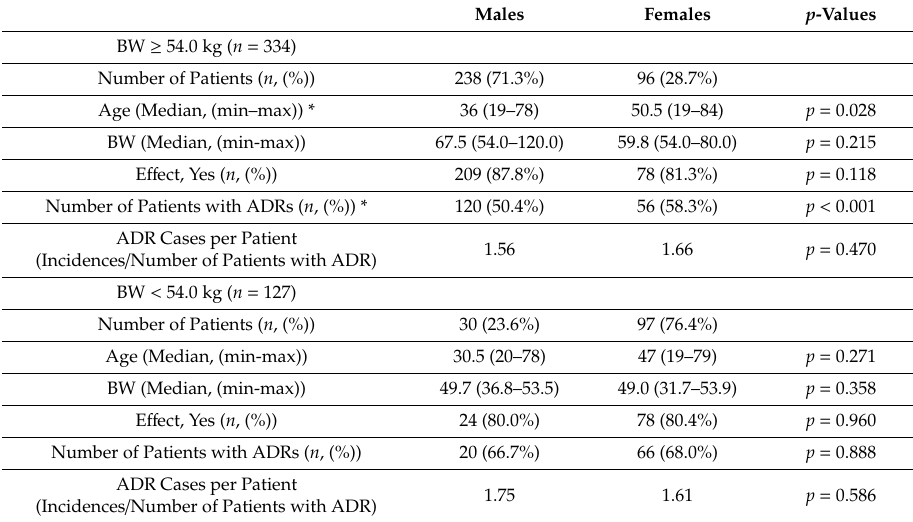
Table 2. ADR incidence rates in subgroups divided by the cuto ff of female median body weight (BW) (54 kg).